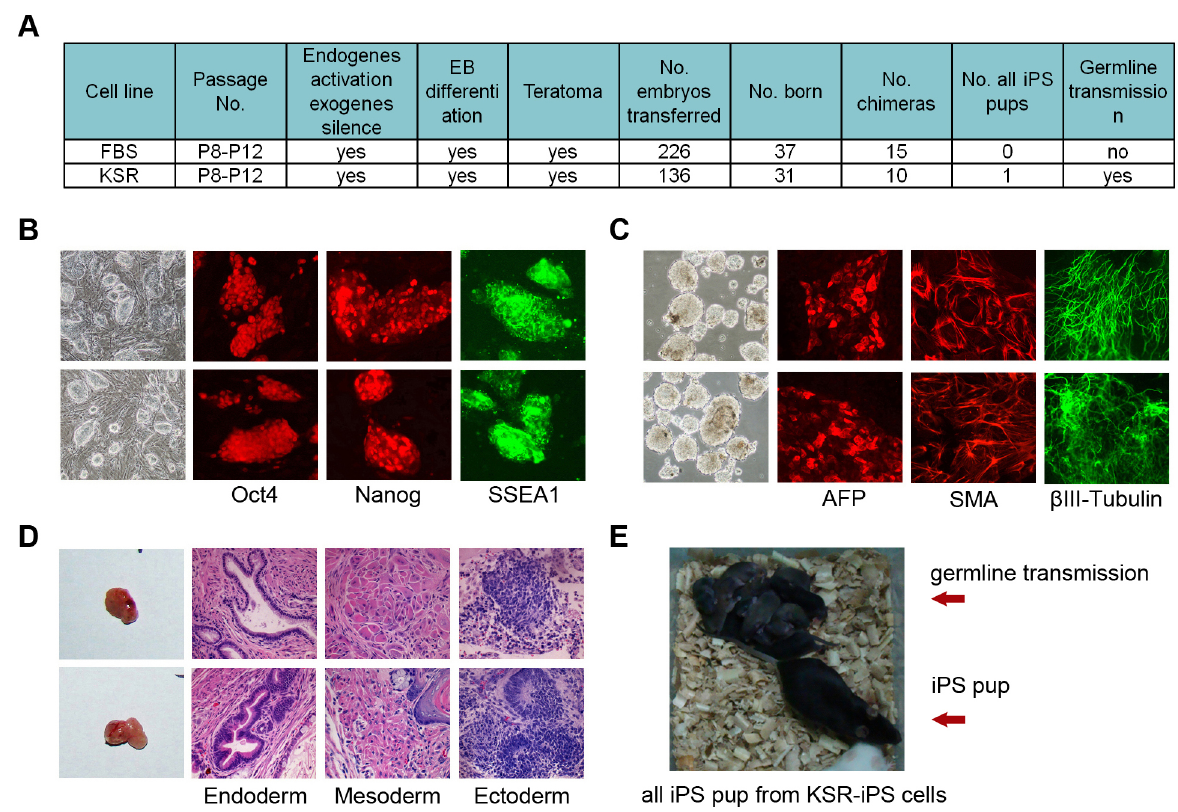
Figure 4. Comparison of pluripotency between iPS cell lines derived from adult fibroblasts under the induction condition of FBS or of KSR. (A) Summary table showing comparison of pluripotency between FBS group and KSR group at passage 12. (B–D) Characterisation and comparison of FBS group (upper) and KSR group (lower) at P12 by morphology and by immunofluorescence staining with ES markers (Oct4, Nanog and SSEA1) (B); EB formation and EB differentiation (endoderm marker AFP, mesoderm marker SMA, and ectoderm marker b -III-tubulin) (C); teratoma formation and HE staining of teratoma tissues: epithelium (endoderm), muscle (mesoderm), neural (ectoderm) (D). (E) All iPS cell-derived pup (black) with germline transmission produced from KSR group.